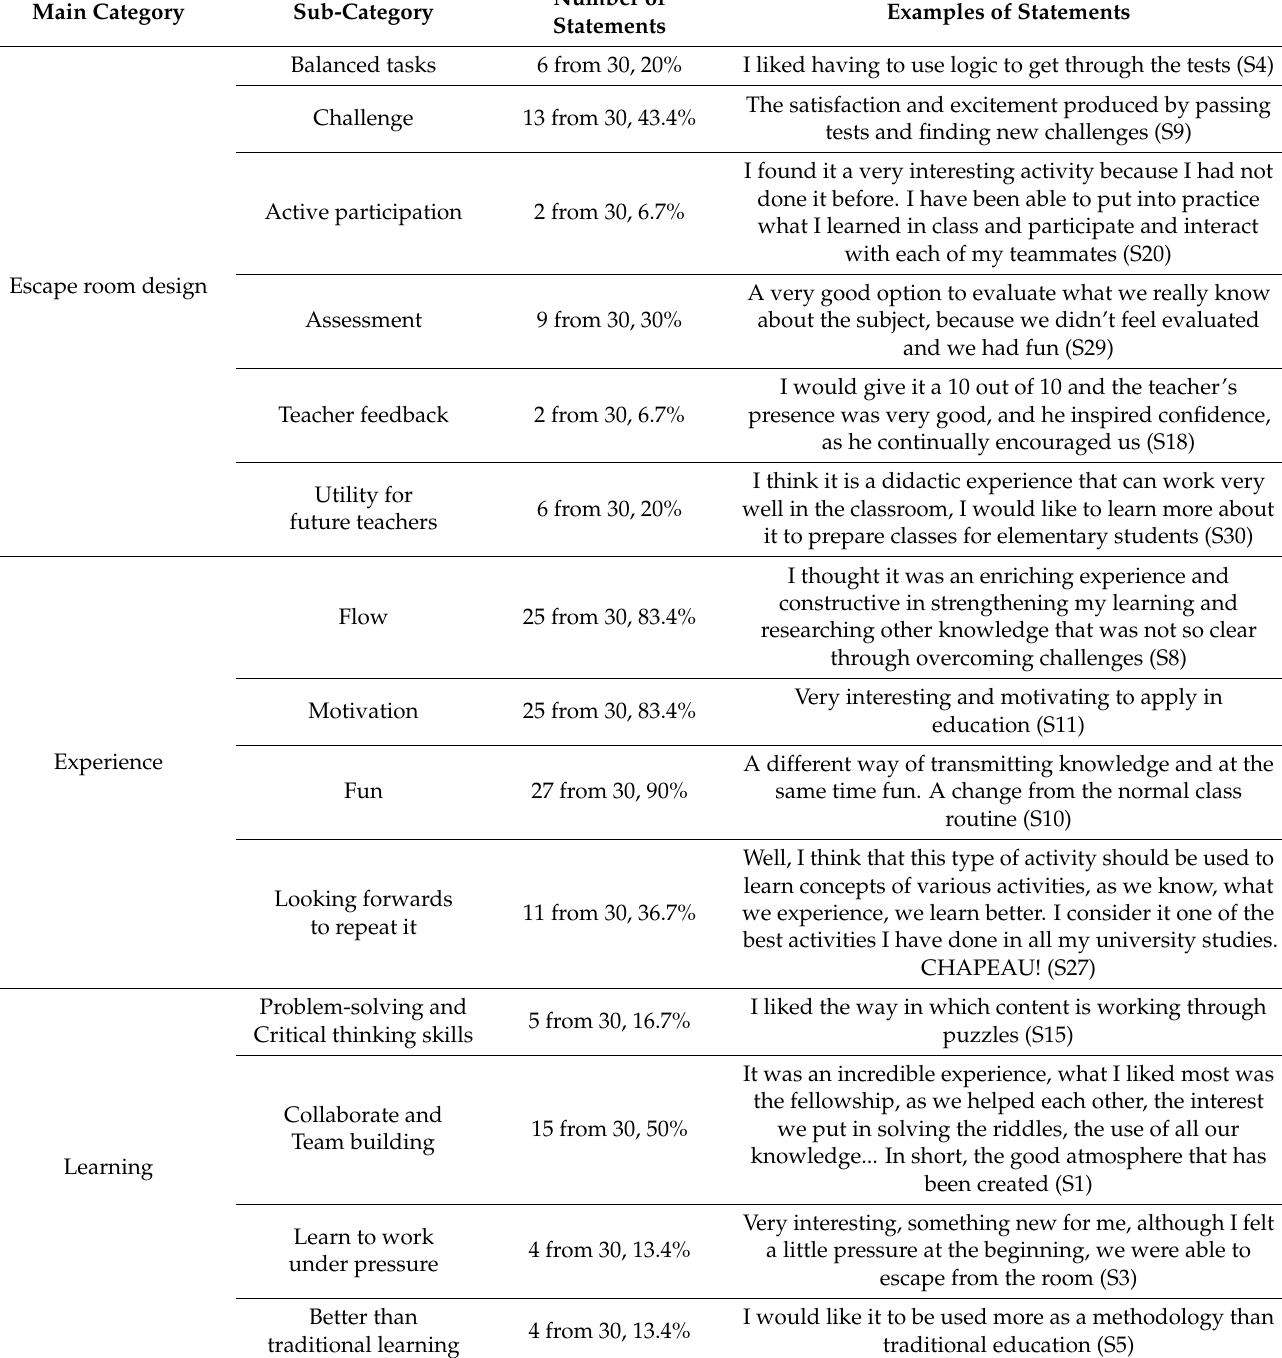
Table 2. Qualitative results after implementing the escape